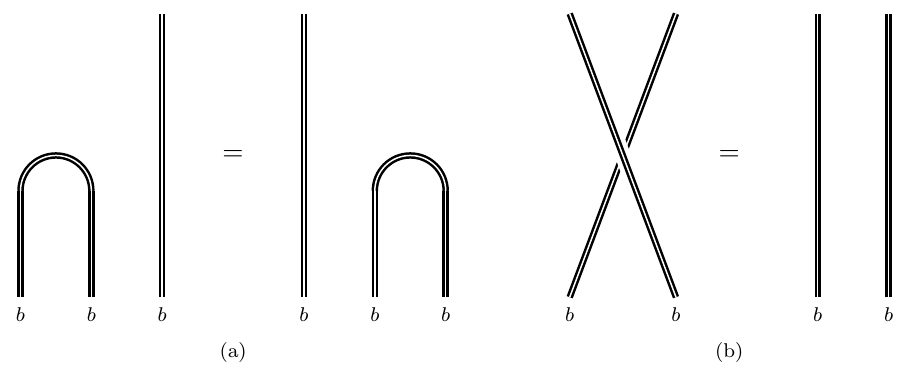
Figure 23 . The properties of a bulk line b generating a non-anomalous Z 2 1-form symmetry are very similar to that of (cid:5). The only di(cid:11)erence is that crossing b lines doesn’t lead to a sign.